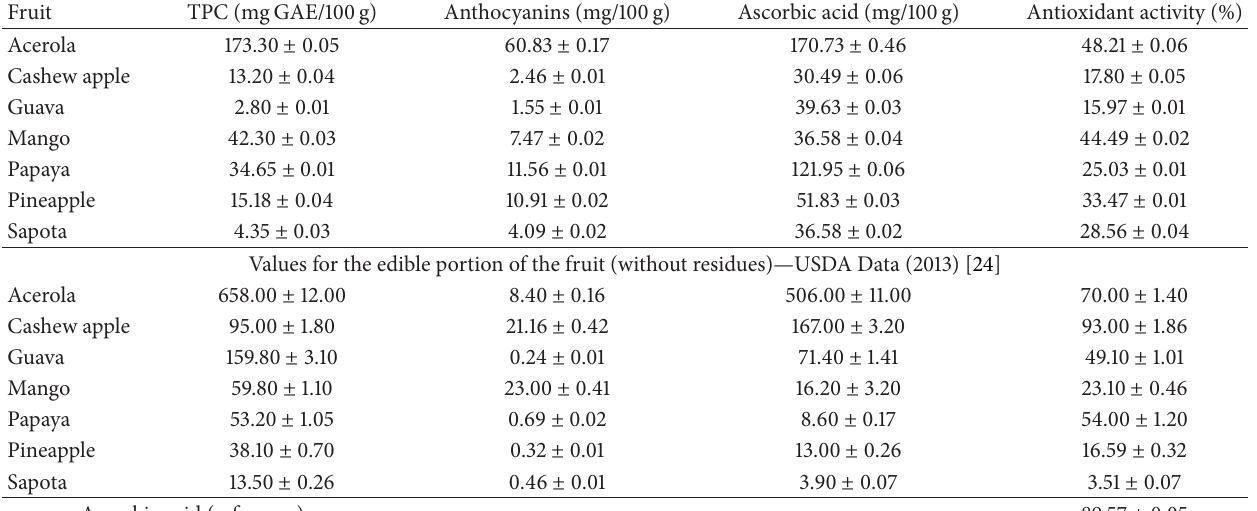
Table 3: Functional properties in fruits residues and in the edible portion of the fruit. Fruit